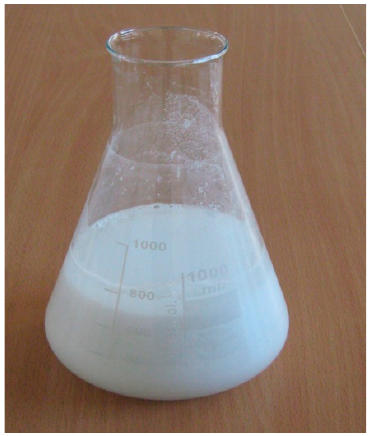
Figure 1. Prepared lime